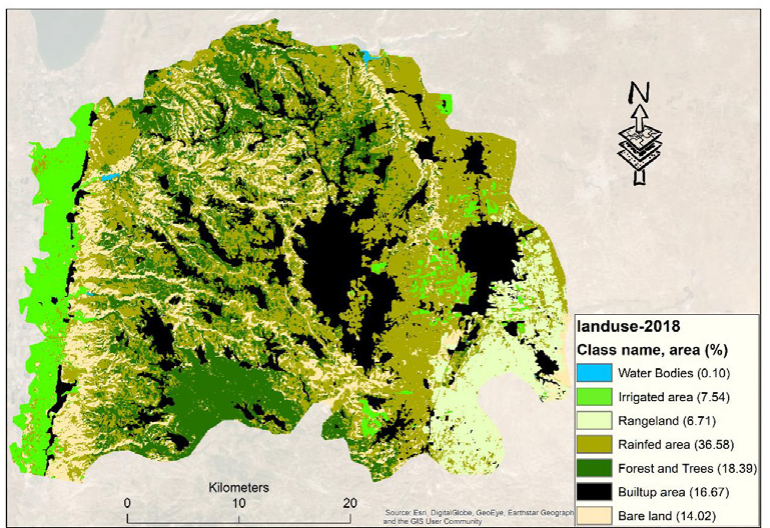
Fig. 3e: Land use in Irbid governorate in 2018